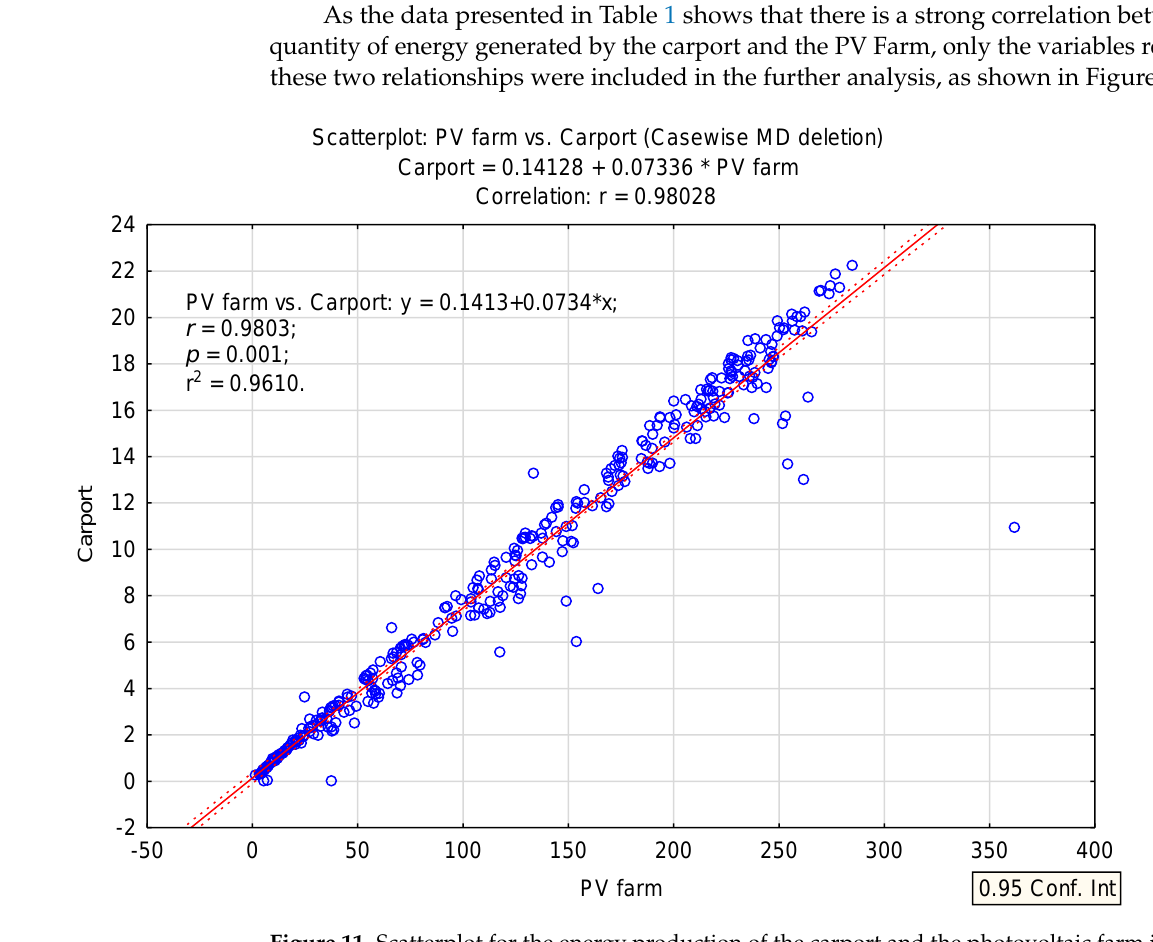
Figure 11. Scatterplot for the energy production of the carport and the photovoltaic farm in Sector 4 of the LSTP.